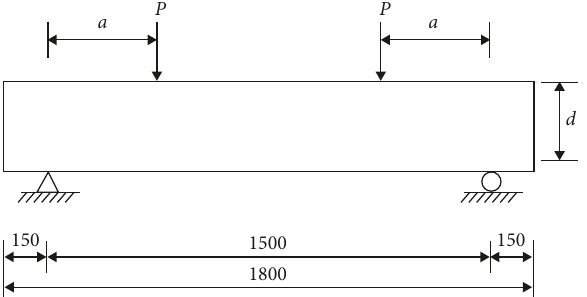
Figure 9: Shear span to depth ratio a/d .